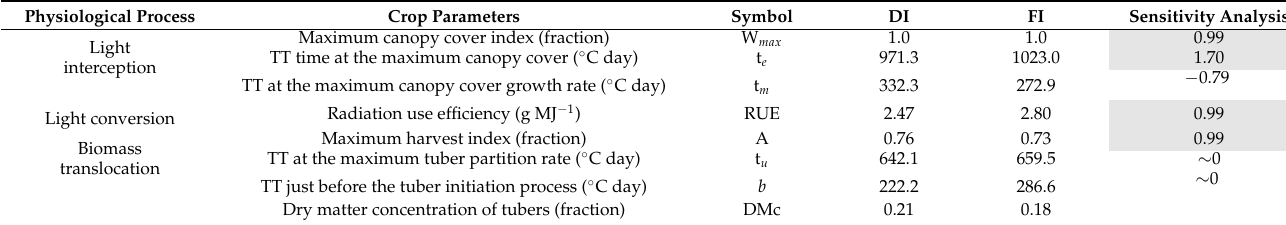
Table 2. Coefficients obtained from potential conditions (based on Trial B’s control treatment) for the calibration of the SOLANUM model under drip irrigation (DI) and furrow (FI) irrigation and sensitivity analysis (in % % − 1 ) expressed as a percentage of the variation in fresh tuber yield (t ha − 1 ) affected by a percentage of the variation in the input parameters of the SOLANUM model. TT = thermal time (calculated as in McMaster and Wilhelm [43]). In gray, the selected parameters with the sensitivity analysis values ≥